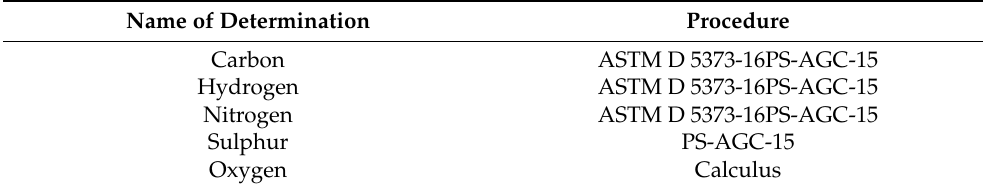
Table 3. Chemical determination procedure.